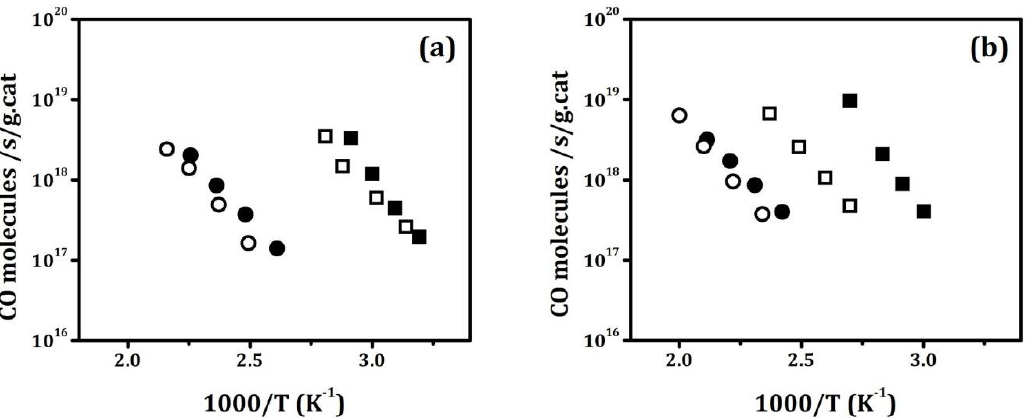
Figure 4. Differential CO oxidation for various samples after the addition of 1 wt % Pd. The samples in ( a ) were calcined to 773 K and the samples in ( b ) to 1073 K. Pd was added after calcination. The samples are as follows: ( ■ ) 20 CeO 2 /ZrO 2 ; (●) 20 ZrO 2 /ZrO 2 ; ( ○ ) unmodified ZrO 2 ; (□) unmodified CeO 2 .